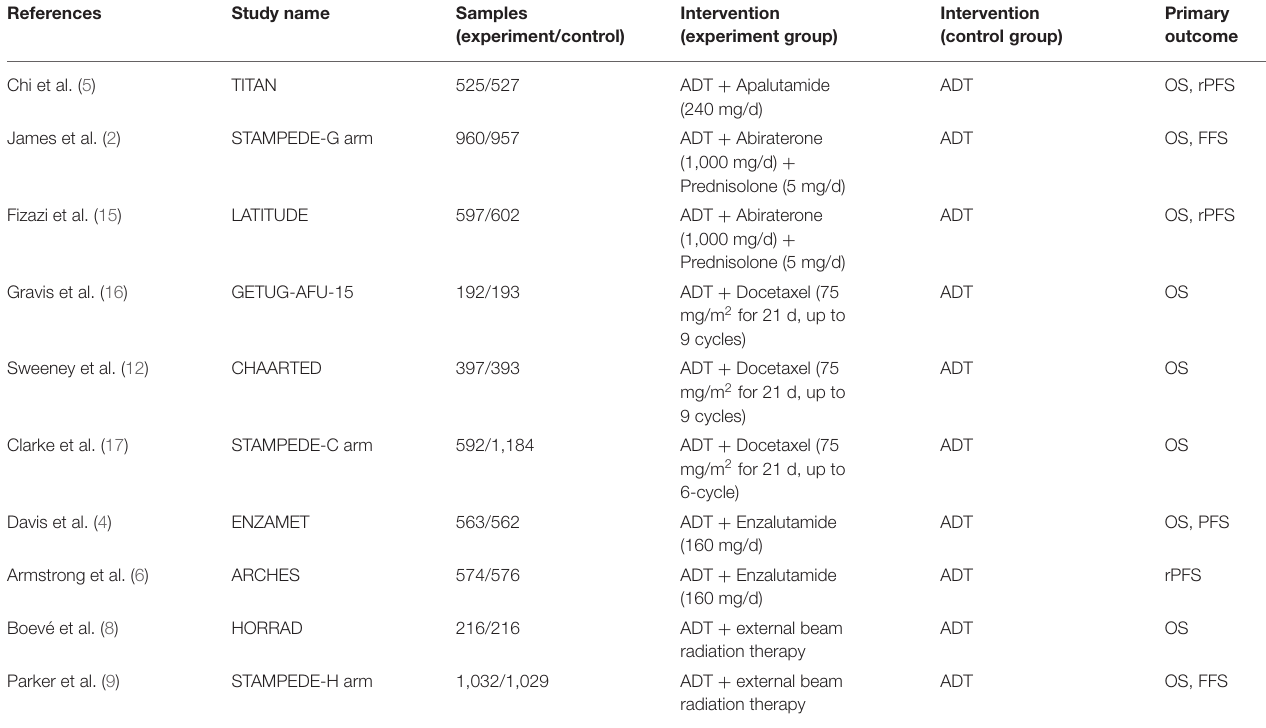
TABLE 1 | Characteristics of included randomized clinical trials in this analysis.